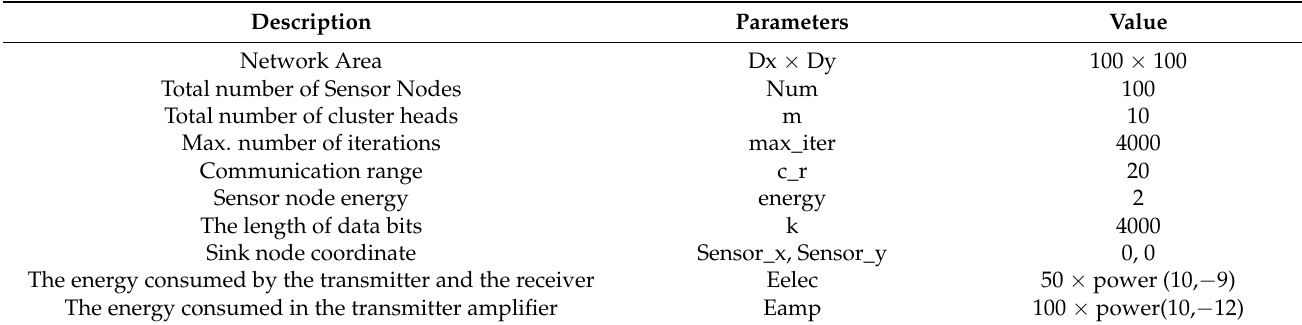
Table 1. List of simulation parameters for the proposed algorithm.